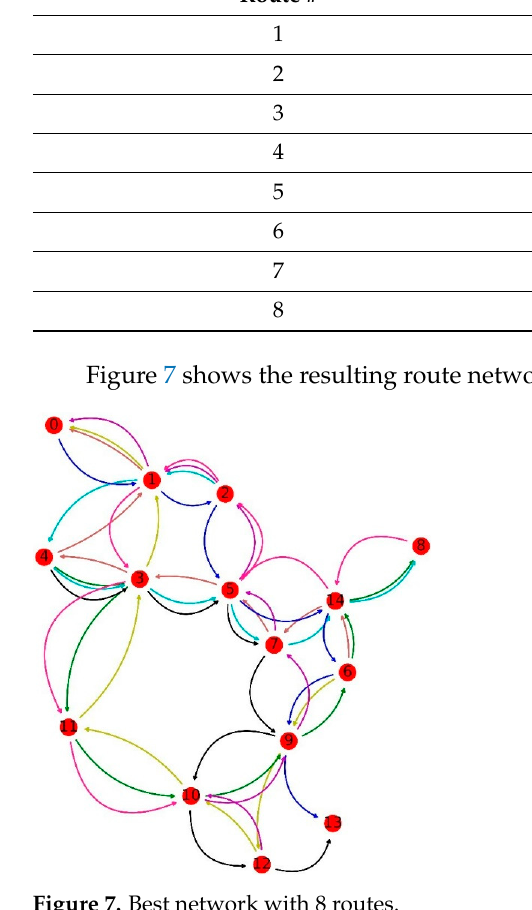
Table 7. Comparison of the final solution generated between methods for 8-Route Case.